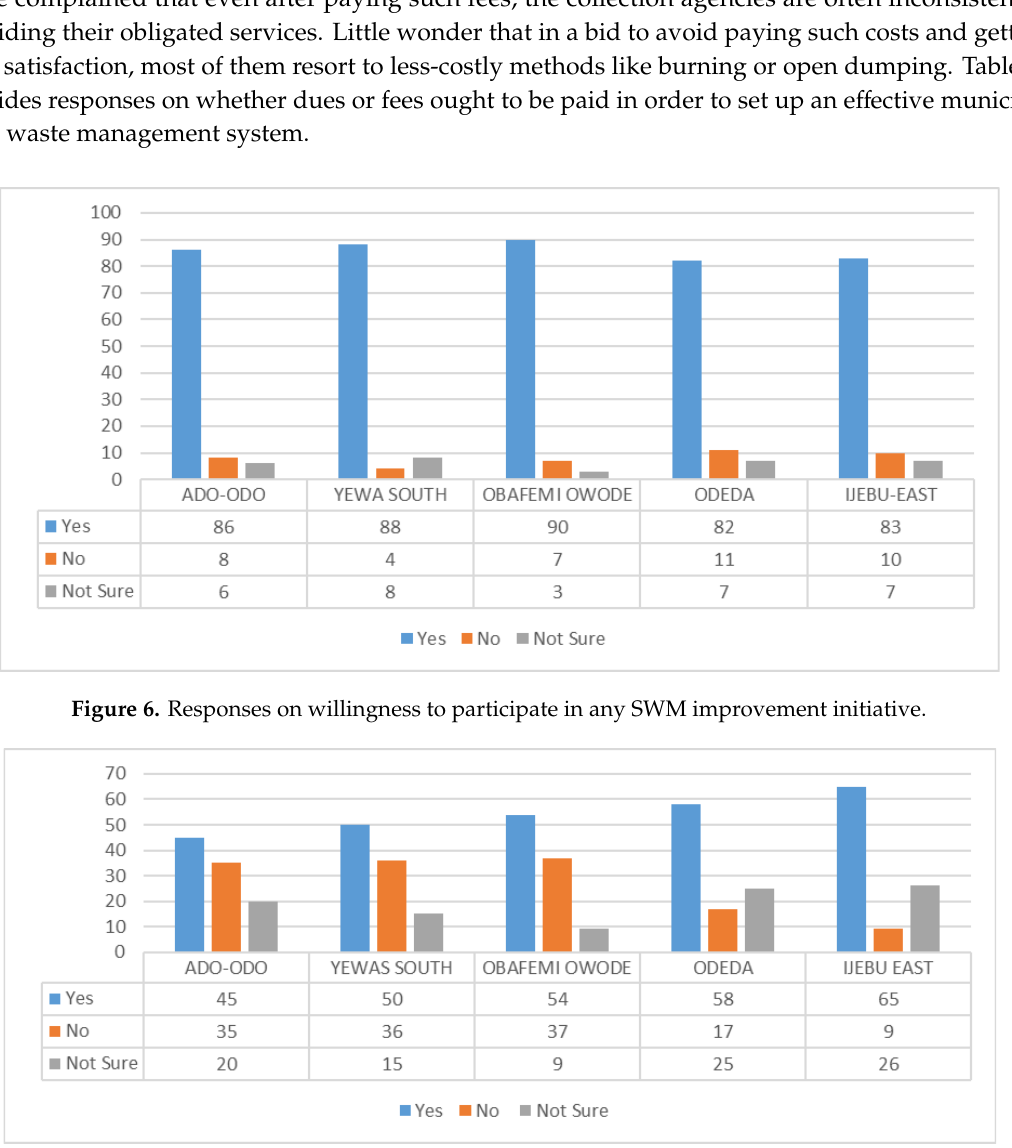
Figure 7. Is SWM a costly endeavour to the community?